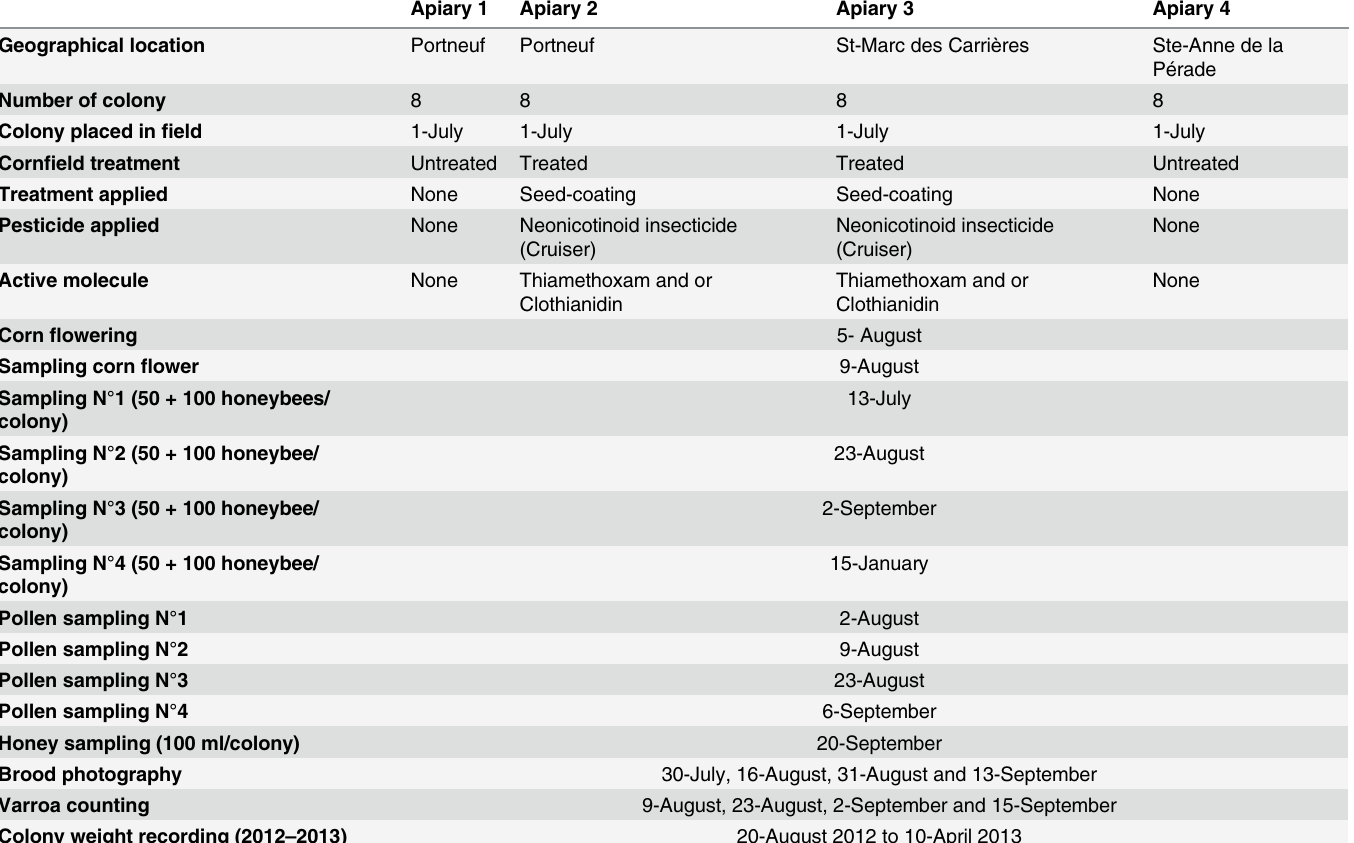
Table 1. Timetable of all the procedures taken in this